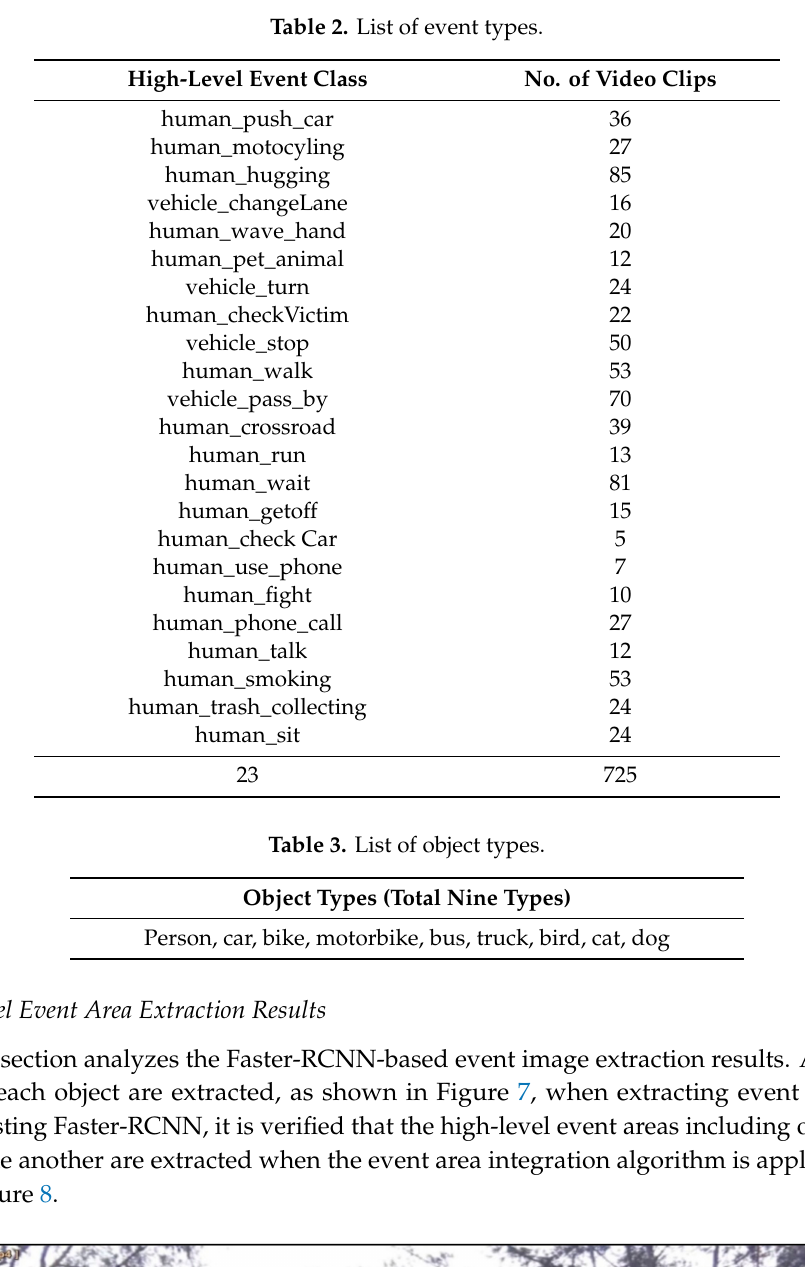
Table 2. List of event types.